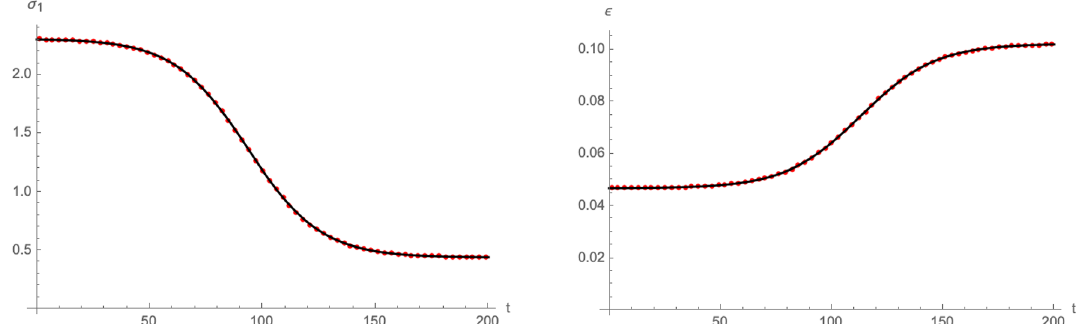
Figure 2. Time dependence of the infection rate σ 1 (left panel) and the removal rate ε (right panel) needed to reproduce and I c ( t ) of the form (9) with the compartmental model (1) (red dots). Both plots use A 0 = 0.025 , = 0.06 , t = 100 , τ = 14 , ρ = 0 , ζ = 0 , σ = 0 . The interpolating black lines correspond = 1 and V (cid:31) 0 0 0 2 /σ 1 to approximations with logistic functions following (11) with notably A σ = 1.87 , δ σ = 0.44 , A ε = 0.055 and δ ε = 0.047 .